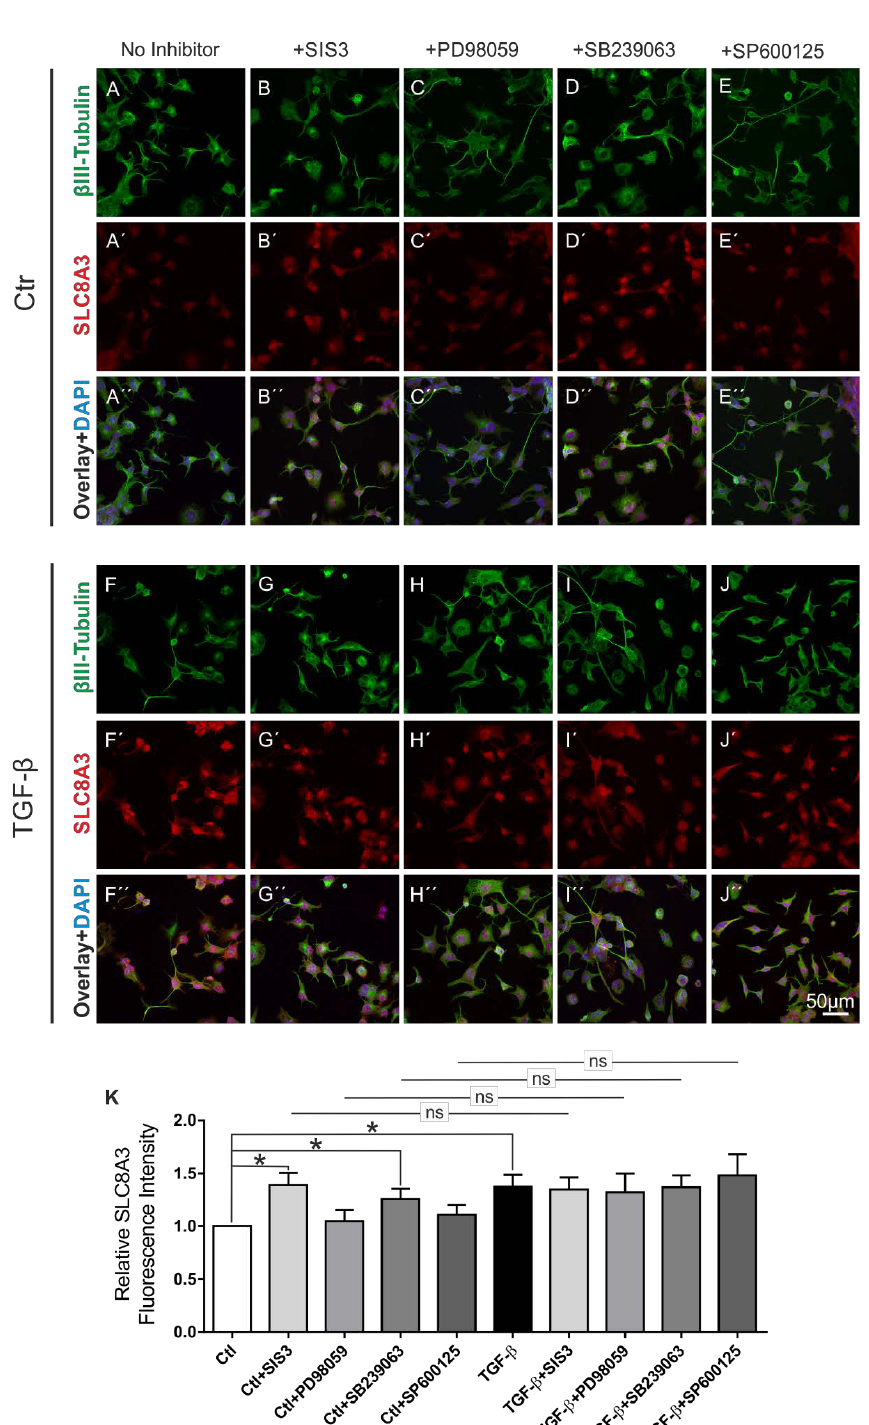
Figure 4. TGF- β canonical pathway and p38 pathway regulate basal SLC8A3 levels. Confocal double immunofluorescence for SLC8A3 (red) with the neuronal marker β -III tubulin (green) in control (ctl; untreated) ( A – E ) and TGF- β -treated ( F – J ) MN9D cells for 60 min following application of the inhibitor of Smad3 SIS3 (3 µ M; B – B (cid:48)(cid:48)(cid:48) , G – G (cid:48)(cid:48)(cid:48) ), or the MAP kinase inhibitor PD98059 (25 µ M; C – C (cid:48)(cid:48)(cid:48) , H – H (cid:48)(cid:48)(cid:48) ), or the p38 inhibitor SB239063 (10 µ M; D – D (cid:48)(cid:48)(cid:48) , I – I (cid:48)(cid:48)(cid:48) ), or the inhibitor of JNK signaling SP600125 (10 µ M; E – E (cid:48)(cid:48)(cid:48) , J – J (cid:48)(cid:48)(cid:48) ), ( K ) Quantification of SLC8A3 fluorescence intensity, * p < 0.05, ** p < 0.01, using the two-tailed unpaired Student’s t-test or one-way ANOVA and Bonferroni post hoc test, total 979 cells analyzed from 5 independent experiments. The values of control were set to